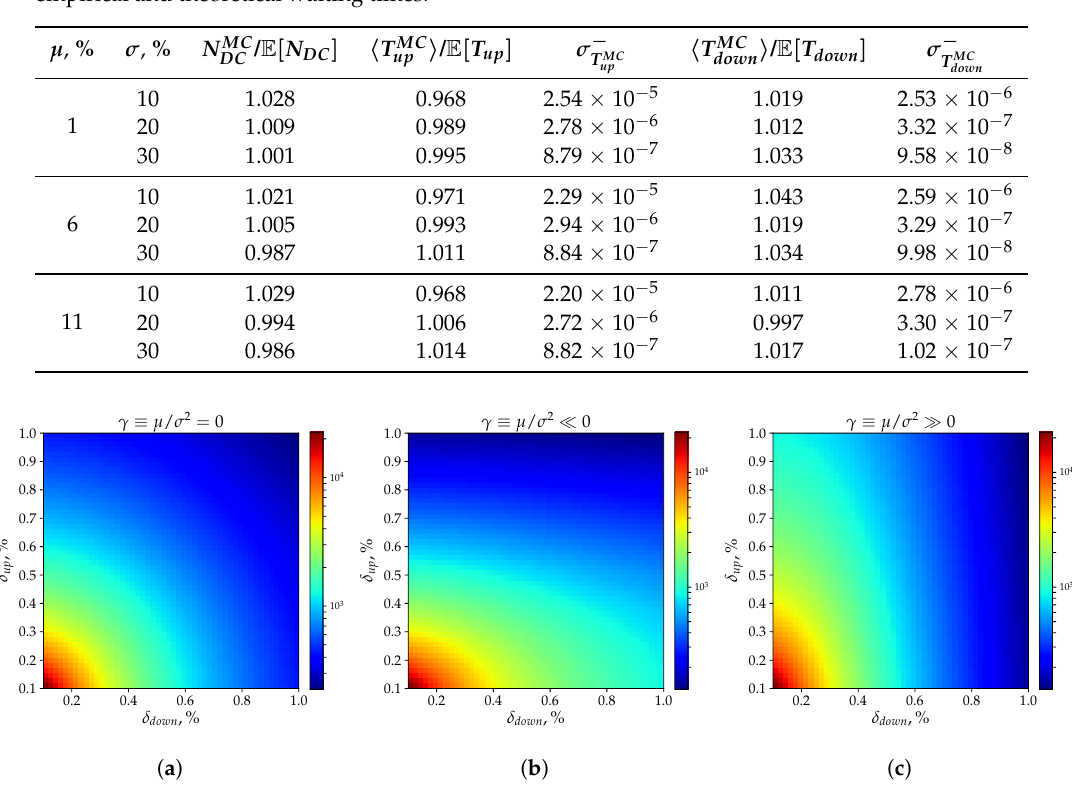
Table 1. Waiting times and number of directional changes in a Monte Carlo simulation. µ and σ are parameters of the Brownian motion used for the test. There are 10 9 ticks in the simulated time series. N MC , , and are the numbers of directional changes and the average waiting times T MC up T MC DC down (cid:105) (cid:104) (cid:105) (cid:104) registered in the Monte Carlo simulation. E [ N DC ] , E [ T up ] , and E [ T down ] are theoretical values dictated by Equations (16), (10) and (11) correspondingly. Values σ − and σ − are standard deviations of T MC up T MC down empirical and theoretical waiting times.